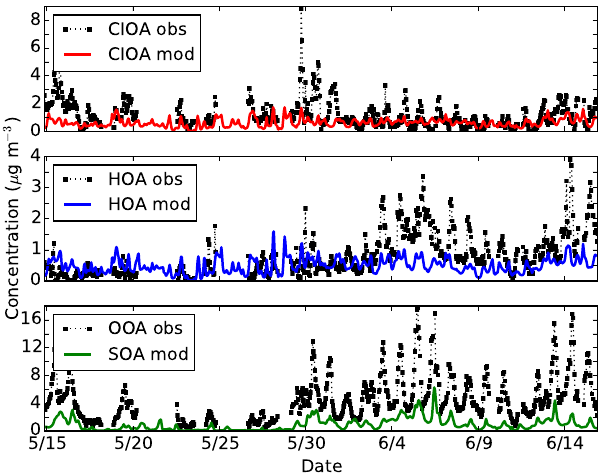
Figure 3. Hourly AMS-measured (CIOA obs) and CMAQ-VBS predicted (CIOA mod) meat cooking POA (top), hydrocarbon-like OA (HOA) and ncPOA (middle), and OOA (SV-OOA + LV-OOA) and SOA (bottom) at